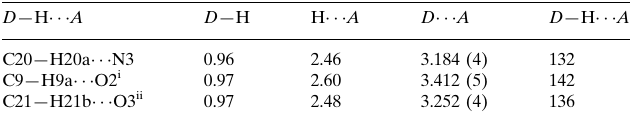
Hydrogen-bond geometry (A˚ , (cid:3)